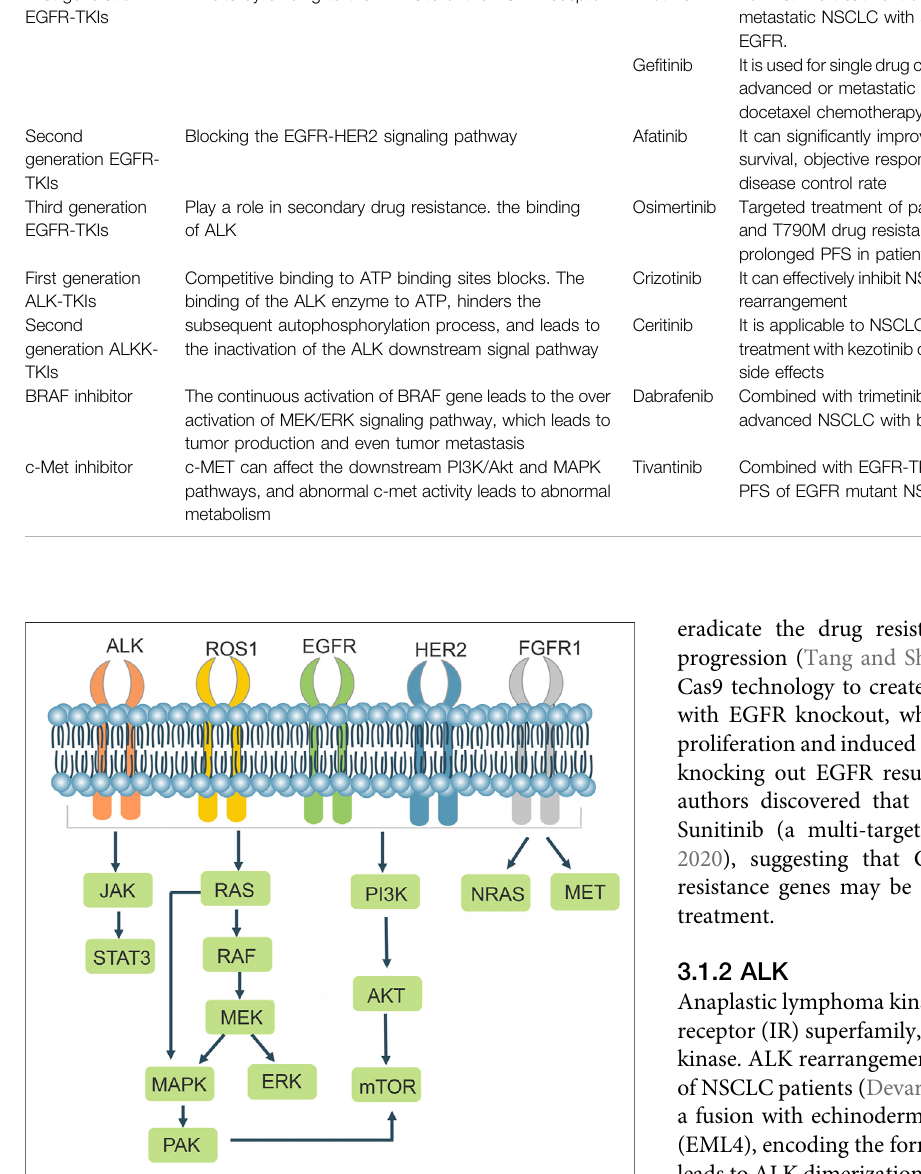
FIGURE 3 | Cell signaling in NSCLC drug